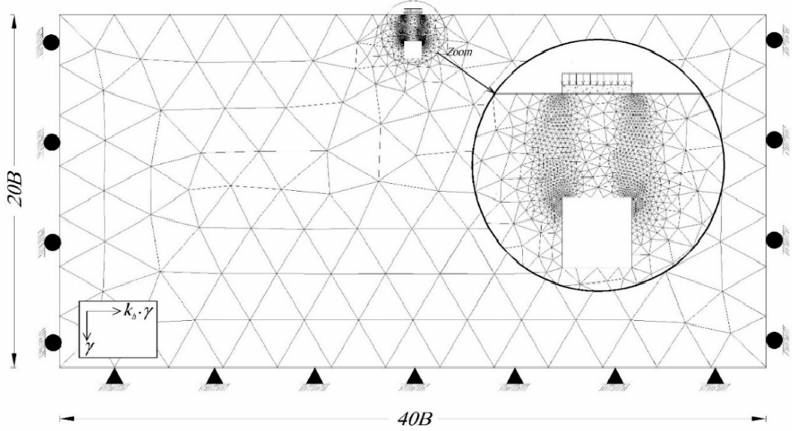
Figure 2. Typical FELA mesh for the studied problem with a close-up to show the adaptive mesh refinement around the void, where the collapse mechanism is expected to form.